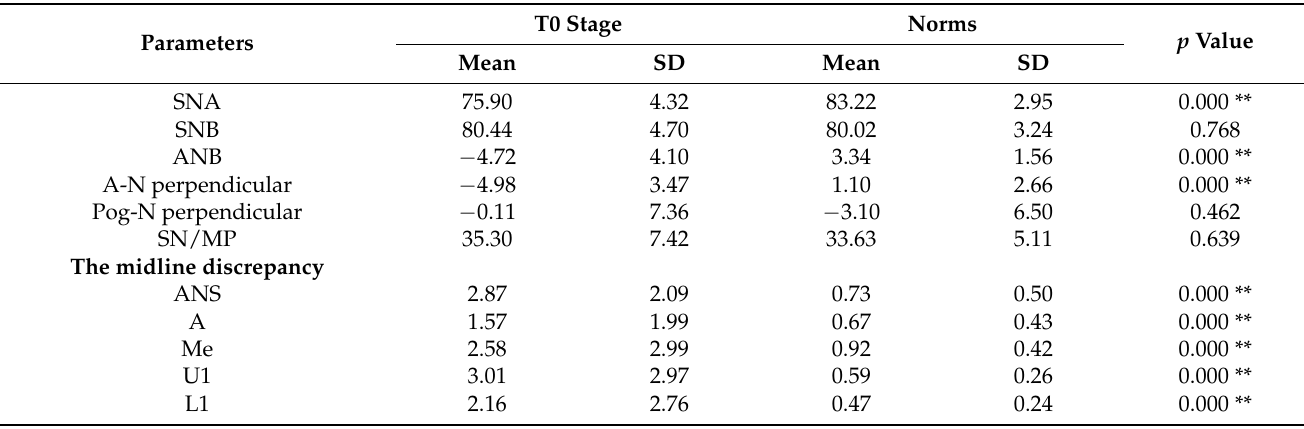
Table 2. The 3D cephalometric measurements of the preoperative image (T0 stage) and the compar- isons with normative data.